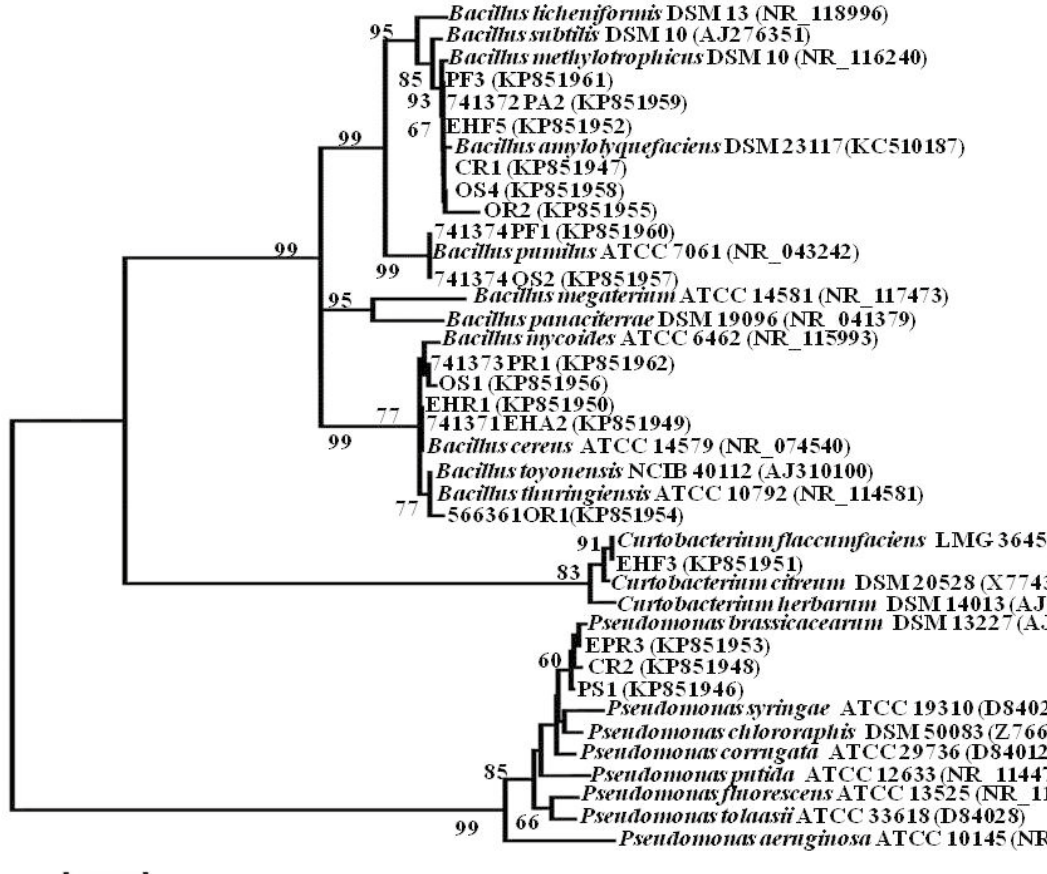
Figure 1. Phylogenetic tree showing evolutionary relationships of endophytic strains of Bacillus spp., Curtobacterium flac- cumfaciens and Pseudomonas spp., as indicated by using neighbour-joining analysis. The tree was constructed using partial sequence (1500 bp) of the 16S rDNA